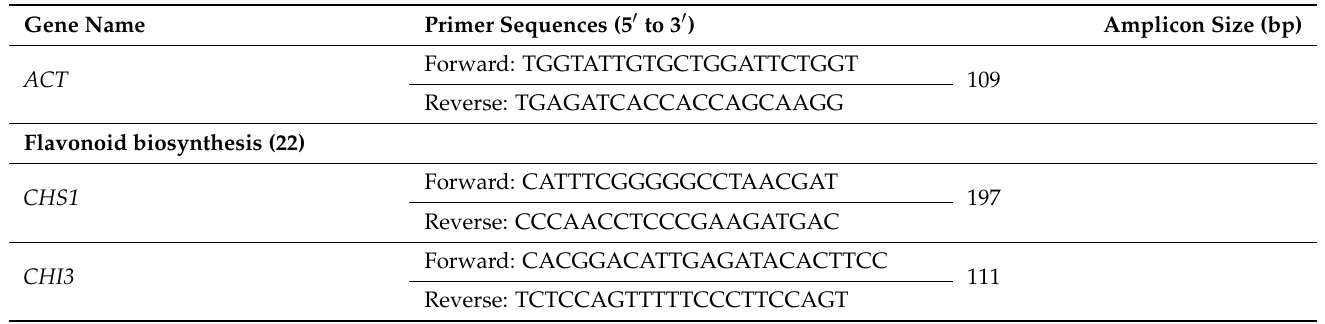
Table 5. Primer sequence of candidate genes used for qRT-PCR